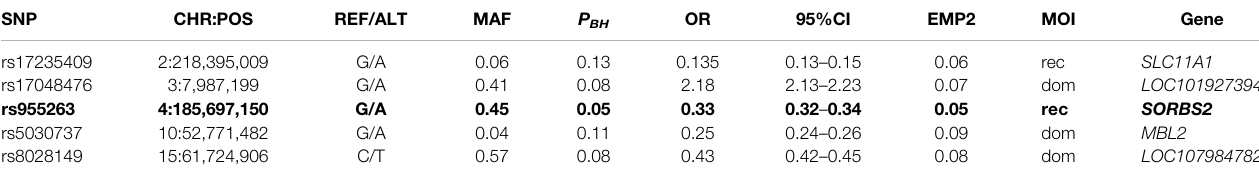
TABLE 3 | Association tests results for controls versus all tuberculosis (TB) cases.